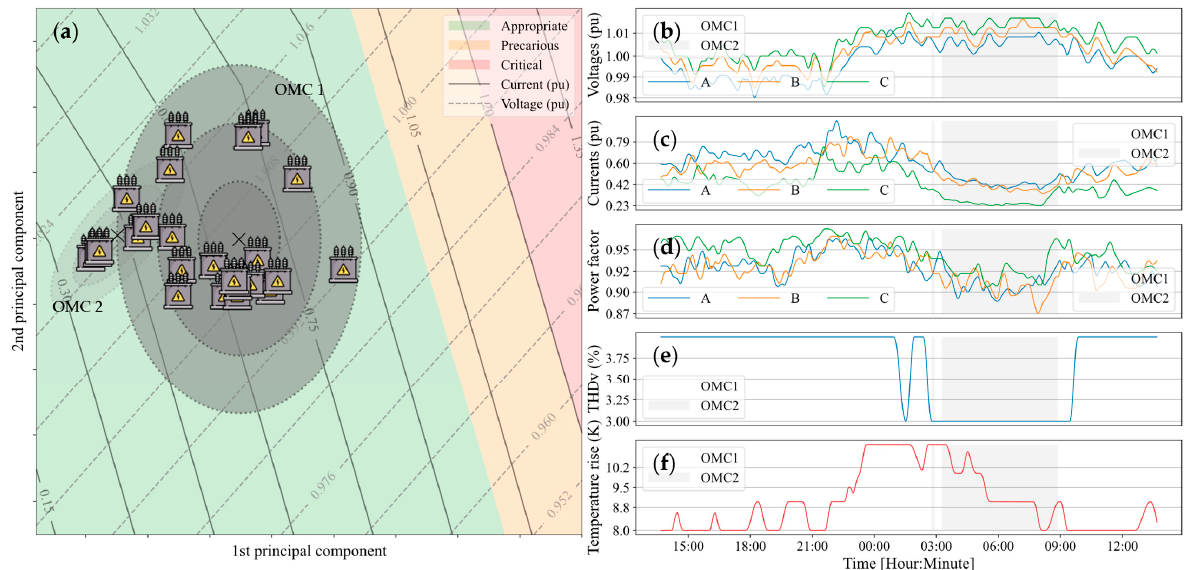
Figure 5. Initialization of transformer 1. ( a ) Shows the initial OMCs and the OPs at each hour, as well as the operation map. ( b – d ) are the voltages and currents in pu, and the power factor of phases A , B and C . ( e ) is the total voltage harmonic distortion of the transformer. ( f ) is the temperature rise of the transformer tank in relation to the ambient temperature.